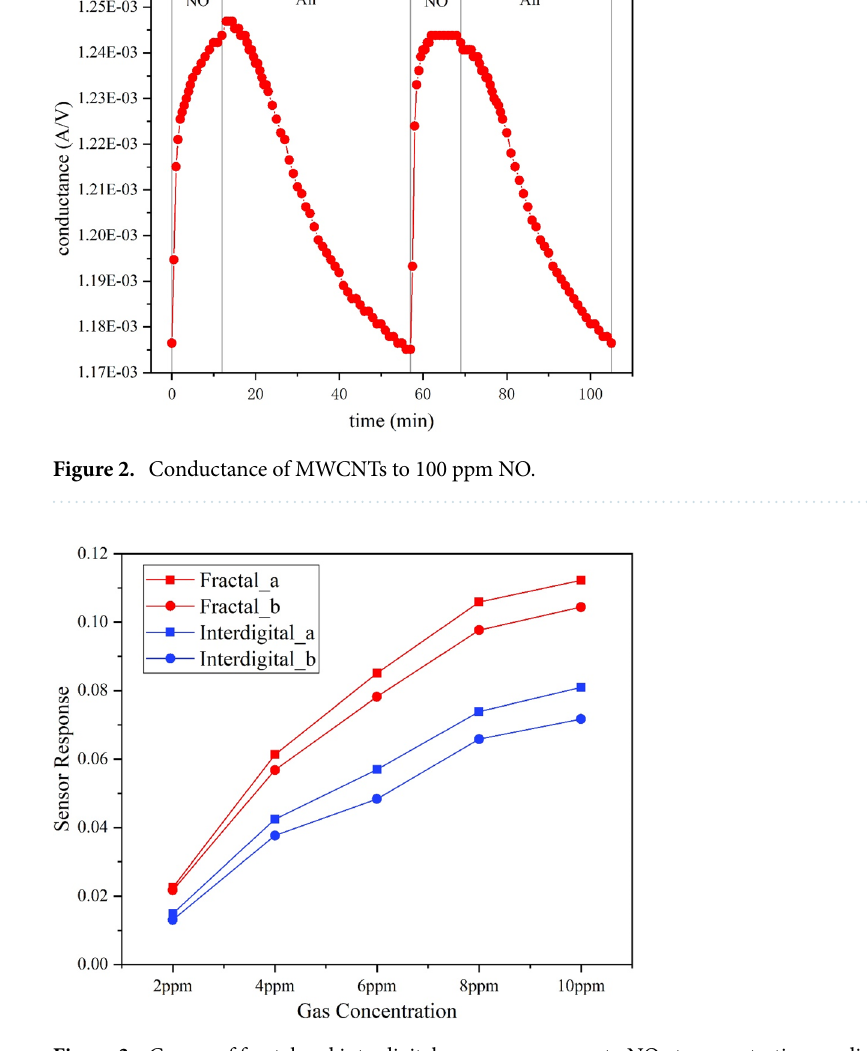
Figure 3. Curves of fractal and interdigital sensors responses to NO at concentration